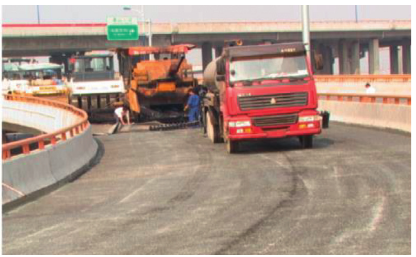
Figure 2: Application of epoxy resin in bridge deck